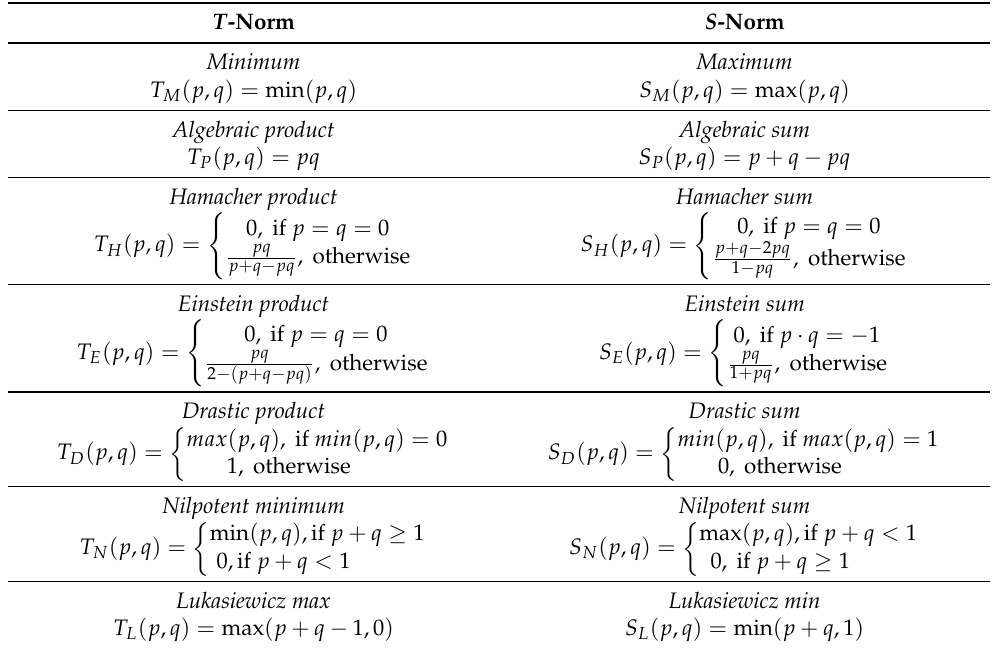
Table 1. Commonly used T -norms and S -norms, where p and q are the state of the concepts j and i ,